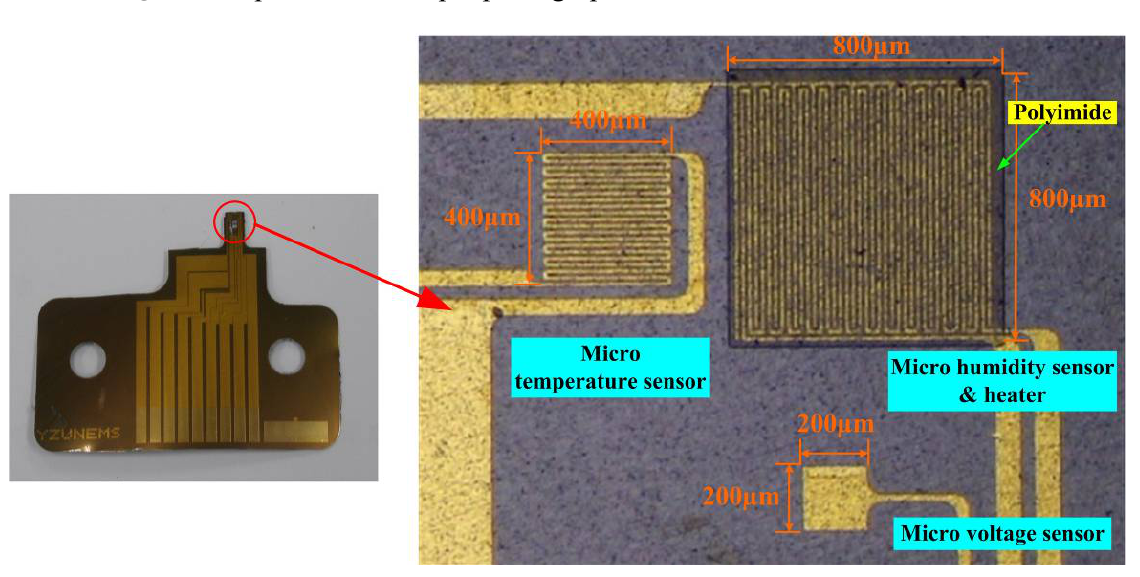
Figure 5. Optical microscopic photograph of multi-functional micro sensor.